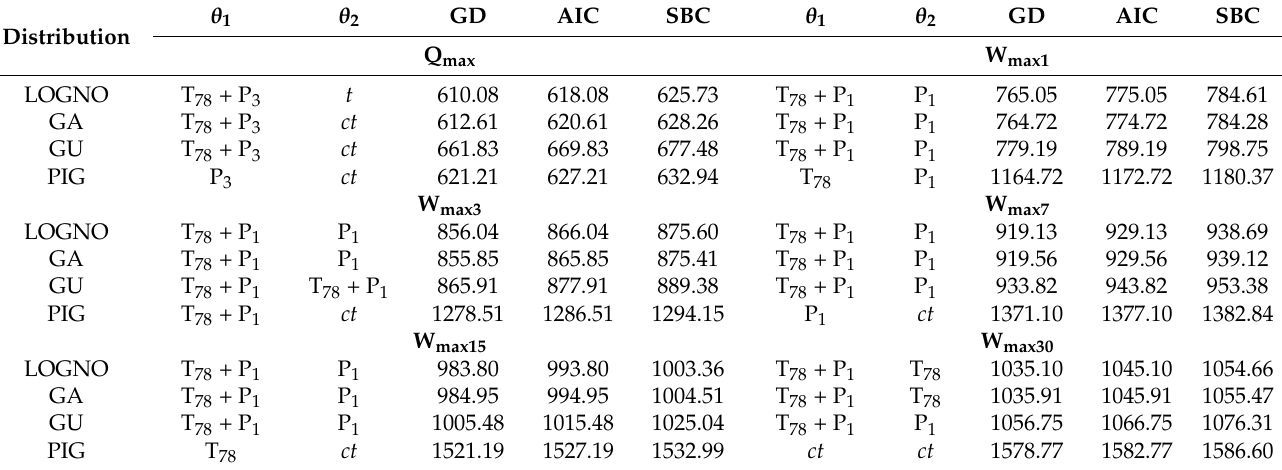
Table 7. Summary for the fitted models type 2 and the type of dependence between Climate factor and the distribution parameters: ct refers to a parameter that is constant. GD denotes the evaluation value of the GD. AIC denotes the evaluation value of the AIC criterion. SBC denotes the evaluation value of the SBC criterion. Lower AIC and SBC represent a better